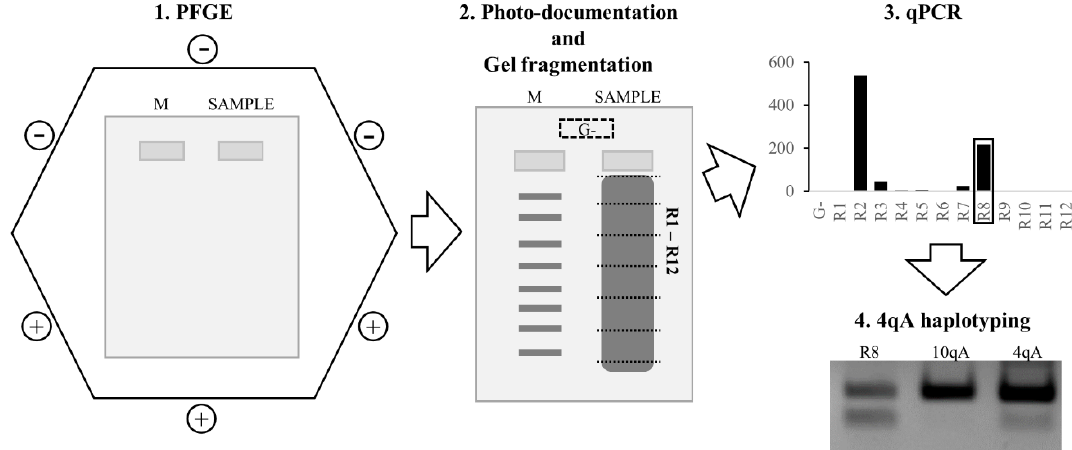
Figure 2. Workflow scheme of the qPCR-based FSHD1 diagnostic approach. Firstly, an agarose-embedded gDNA sample is digested by endonuclease and resolved by PFGE. Secondly, the PFGE–agarose gel is stained in ethidium bromide and photographed. The gDNA lane fragmentation scheme is marked on a photo. The agarose gel lane with digested gDNA is manually fragmented by scalpel according to the fragmentation scheme; usually, 12 gel fragments are obtained. Additionally, for the estimation of agarose gel contamination by the target DNA, the “G-” gel fragment is sliced from the off-line area. Thirdly, all the fragments used as a template for chromosome 4 D4Z4 repeat-specific qPCR. Comparing the qPCR data with the gel fragmentation scheme (position of the gel fragments with maximum target gel concentration against molecular weight marker), a conclusion regarding the length of the D4Z4 array is made. Fourthly, based on the qPCR data, the gel fragment with the maximum concentration of target DNA (R8) is used for 4qA haplotyping by allele-specific PCR. λ 260201 and C85 are used as a control for the 4qA and 10qA haplotypes, respectively. Thus, the described approach provides information about the length of the chromosome 4 D4Z4 arrays and their haplotype—the minimum contributions for an FSHD1 diagnostic approach.